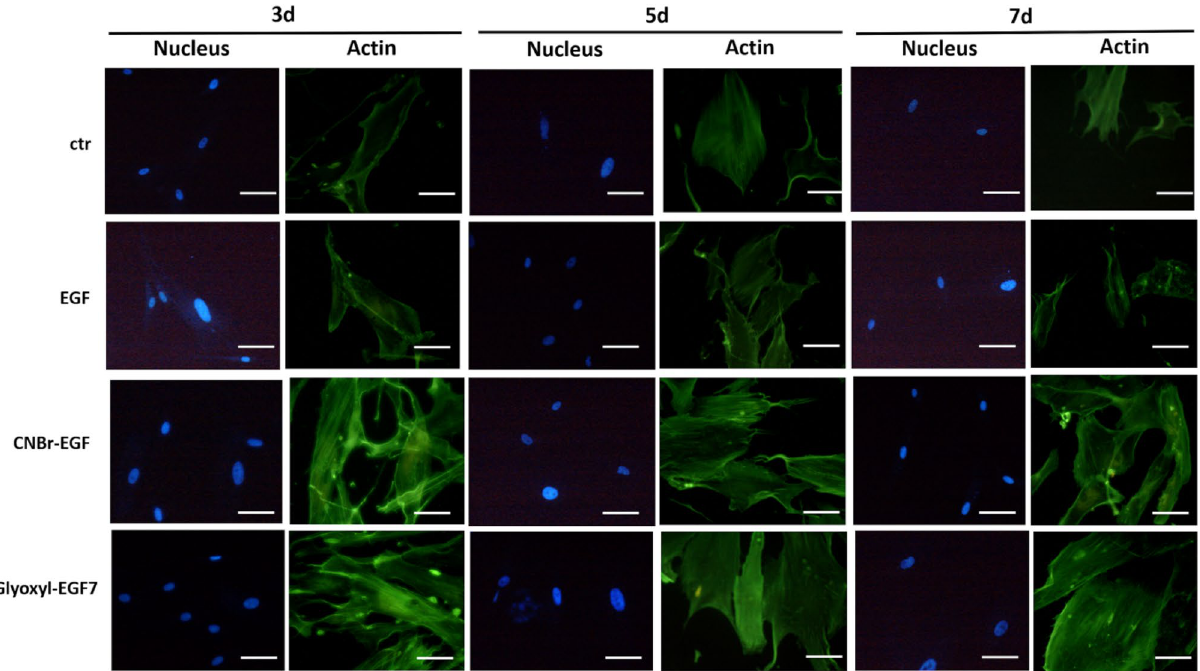
Figure 9. Morphology of NHDF treated with 50 ng/mL soluble-EGF and immobilized-EGF (CNBr-EGF and Glyoxyl-EGF7) incubated for 3, 5 and 7 days. Untreated cells were used as negative control (ctr). After incubation, cells were fixed and stained phalloidin and DAPI. Scale bar, 15